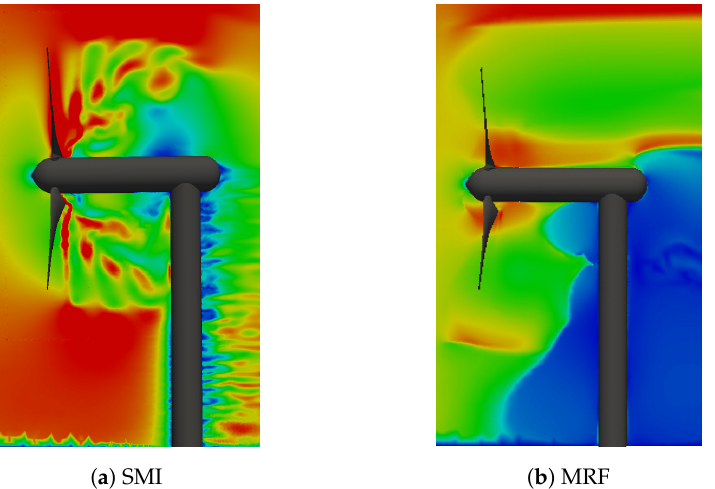
Figure 14. Comparison of flow-pattern for the SMI and MRF simulation techniques on a plane passing through the turbine center. The MRF was shown to provide a good assessment of the large features of the flow field, whereas SMI also accounts for the small features present in the flow field. Note: the velocity magnitude is restricted to 0–1 m/s to provide better